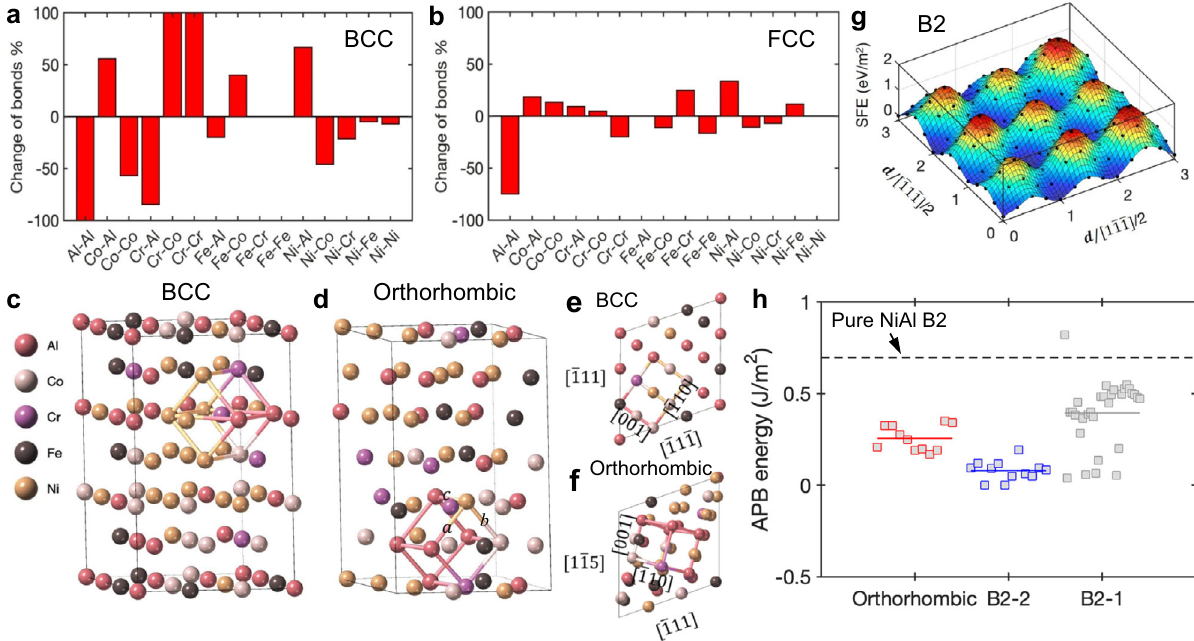
Fig. 5 MC simulation results. a , b First nearest neighbor bonding environment change for BCC and FCC phases, respectively, after the MC simulation. The change is relative to the number of bonds in the initial con fi guration. c – f Structures of the precipitate phase before and after the MC simulation. c Initial BCC structure. d Final ordered orthorhombic structure ( a = 3.014 Å, b = 2.902 Å, and c = 2.571 Å). e top view before MC. f top view after MC. g Generalized SFE distribution of the fi nal B2 phase. h Comparison of APB energies of the B2 phase with different con fi gurations. The dashed line indicates the stacking fault energy of a pure NiAl